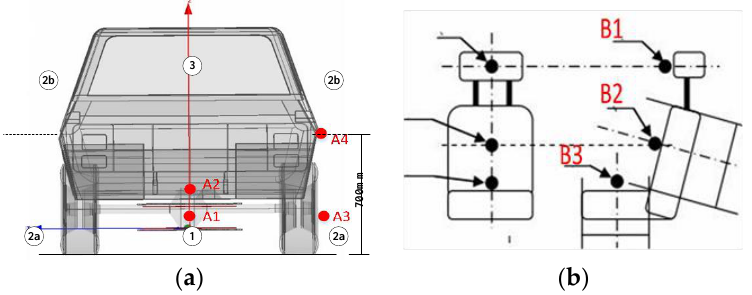
Figure 11. Position of test points; ( a ) position of A1, A2, A3, A4; ( b ) position of B1, B2, B3.